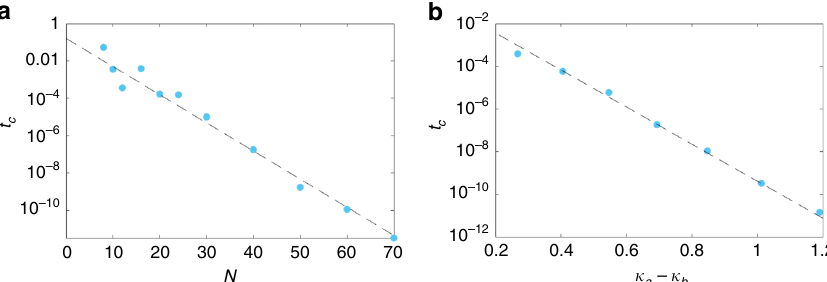
Fig. 6 Inverse exponential scaling of the critical bare coupling t 0 = t c required for the open-boundary spectrum of H 2-chain to make the transition from real to complex. a , b t c Versus the system ’ s size N and effective skin depth κ a − κ b , respectively. The numerical data (blue) fi ts very well with the predicted scaling law t c (cid:3) e (cid:4)ð κ a (cid:4) κ b Þ N = 2 (dashed lines) with κ a (cid:4) κ b ¼ log2 in a and N = 40 in b . Unless speci fi ed in the fi gure, the parameters are t 1 = 0.75, = − δ = 0.25 as in Fig. 2 of the main text. In b , κ δ a b